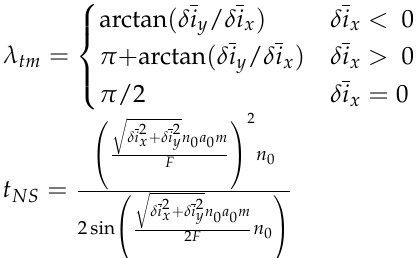
Considering the arc loss, under normal working condition, the mean orbital right ascension λ tm and the north/south ignition duration t NS corresponding to the midpoint of the EP arc are: